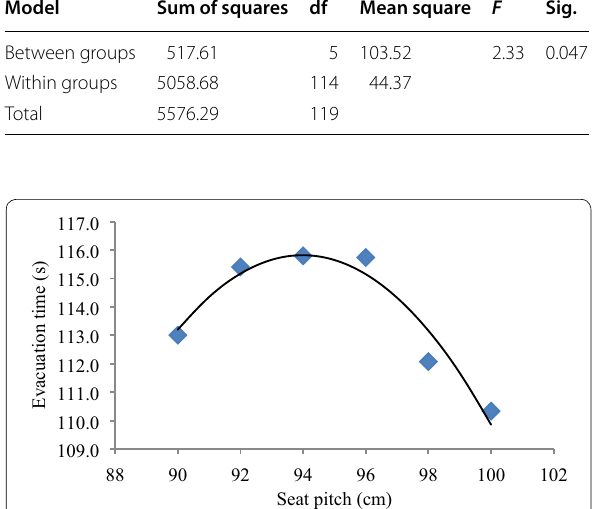
Figure 11 Fitting curve of evacuation time and seat pitch